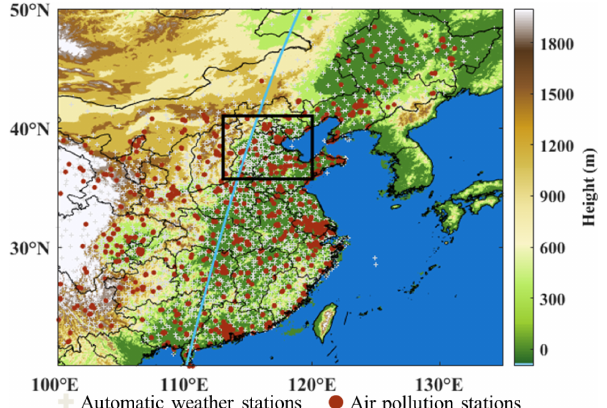
Figure 1. The map and topographic height of the simulated domain. The turquoise line represents a part of the CALIPSO satellite orbit tracks at 18:12 on 7 January 2017, the black rectangle represents the location of Jing–Jin–Ji, the gray cross signs are the automatic weather stations, and the dark-red dots are the air pollution